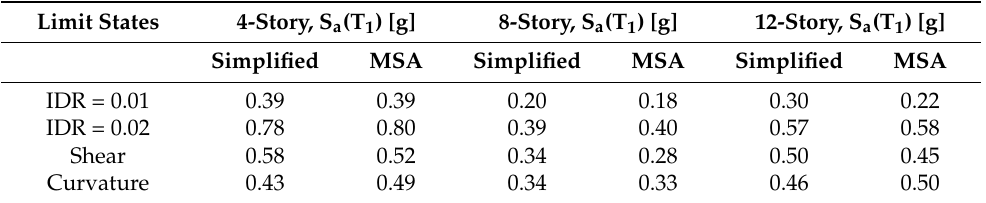
Table 6. Median intensity associated with different failure mechanisms found through the simplified approach and multi-stripe analysis (MSA).